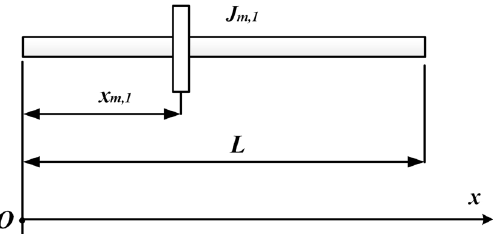
Figure 12. The FF shaft with one moving concentrated inertia.